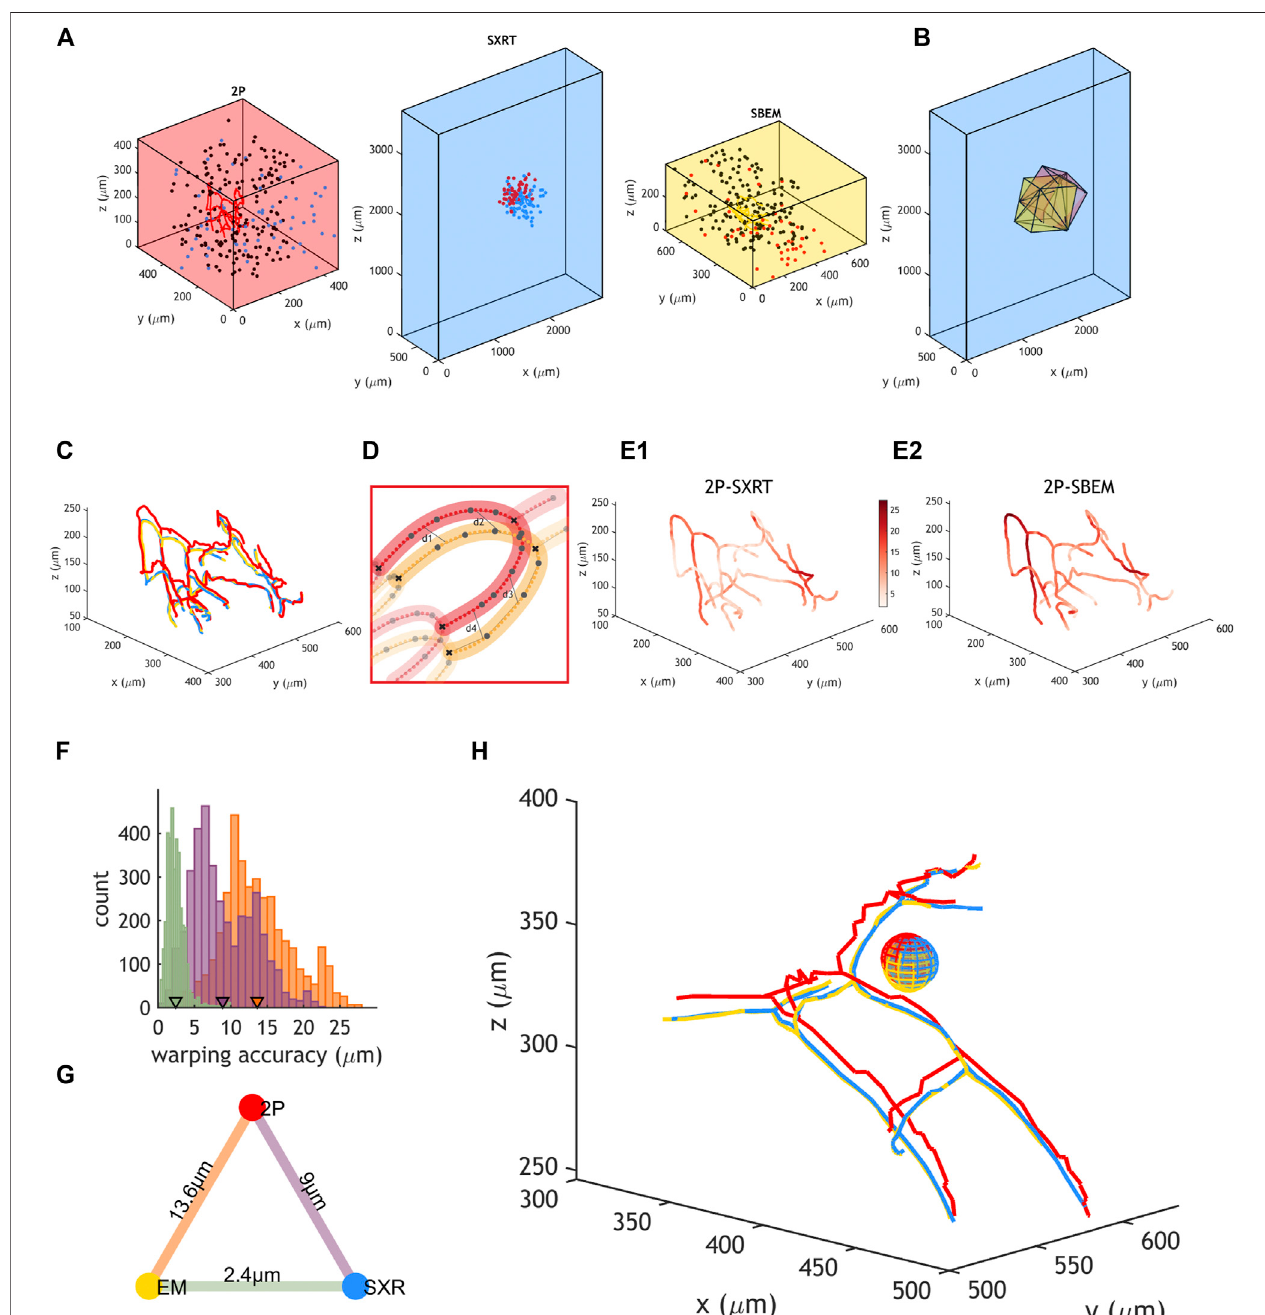
FIGURE 6 | Accurate warping allows for cell correlation among 2P, SXRT and SBEM. (A) Position of landmarks used to generate warping functions between two datasets and position of blood vessel tracings used to quantify warping accuracy in 2P, SXRT and SBEM datasets of a sample. Blue, black and red dots represent landmarks used between 2P and SXRT datasets, between 2P and SBEM datasets and between SXRT and SBEM datasets, respectively. (B) Fields of view of 2P (red, warped), SBEM (yellow, warped) and SXRT (blue, native space) datasets. (C) Same blood vessels traced in the 2P (red, warped), SXRT (blue, warped) and SBEM (yellow, native space) datasets. (D) Quanti fi cation of warping accuracy. The nodes in the blood vessel traced in one imaging modality (red) are paired to the equivalent nodesintheothermodality(yellow). Thedistancebetweentwopairednodes(e.g., “ d1 ” )re fl ectsthewarpingaccuracyatthatlocation.Largedotsrepresentnodesinthe original tracing. Lines represent paths of the original tracing. Small dots represent nodes interpolated along the tracing path. (E1,E2) Native SBEM blood vessel tracing coloured by the mapped 2P-SXRT and 2P-SBEM warping accuracy, respectively. (F) Distribution of warping accuracies (i.e., distances between paired nodes). Purple, orange and green represent 2P-SXRT, 2P-SBEM and SXRT-SBEM accuracies, respectively. Mean warping accuracies are marked by triangles. (G) Mean warping accuracy between each pair of imaging modalities. (H) Example mitral cell and surrounding blood vessels warped from 2P (red) and SXRT (blue) datasets into SBEM (yellow) space. The diameter of the sphere is 20 µm, similar to the diameter of a mitral cell soma.